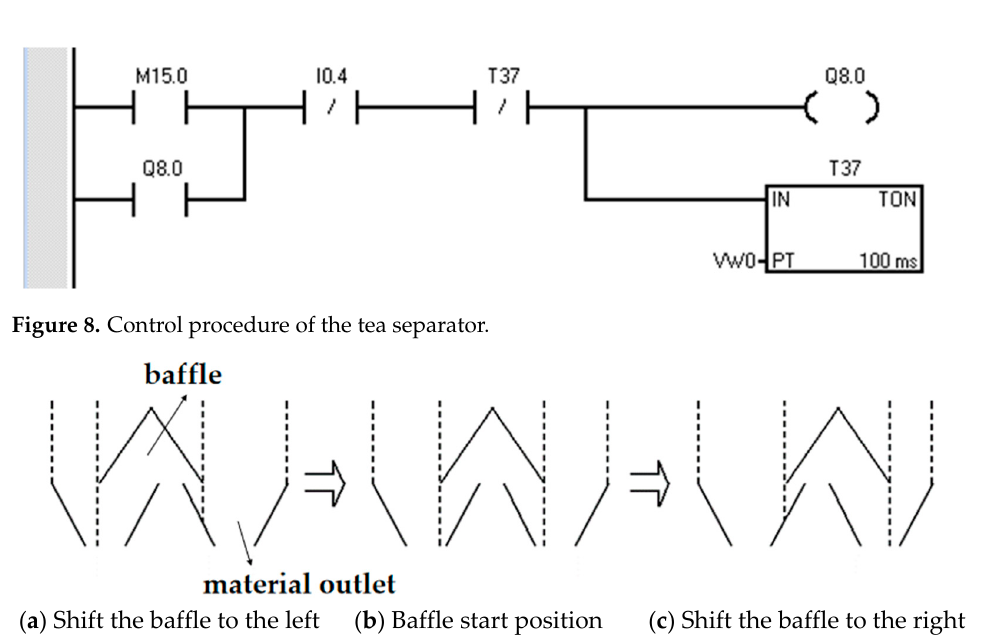
Figure 7. Vibratory feeder control program.